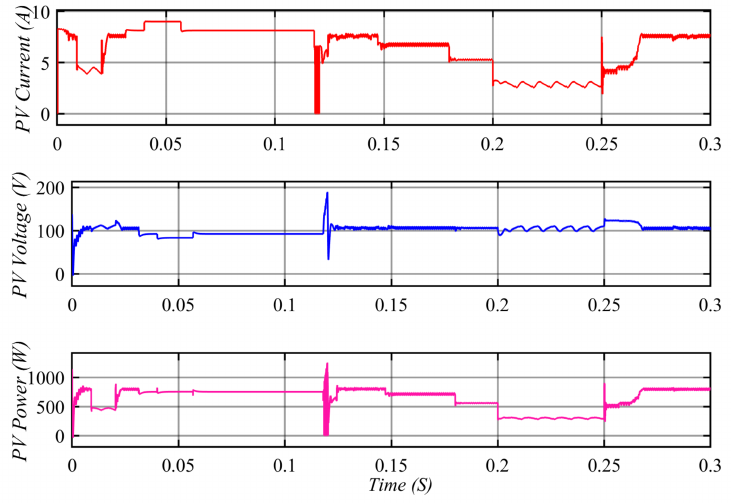
Figure 15. Changes in the first PV array’s current, voltage, and power under load constant and radiation